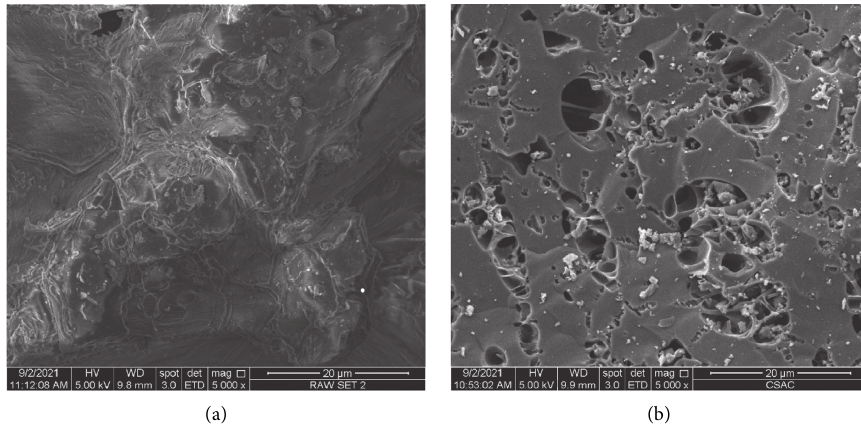
Figure 2: SEM image of (a) coconut shell and (b) CSAC (5000x).